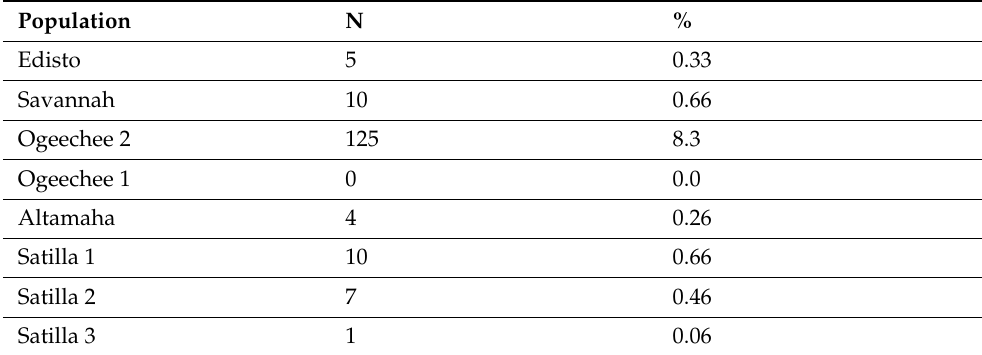
Table 6. Contributions of genetic populations in the South Atlantic DPS to the overall coastal collections of Atlantic sturgeon (n = 1512 specimens) using Individual Based Assignment (IBA) testing based on analysis at 11 microsatellite loci. Population N % Edisto 5 0.33 10